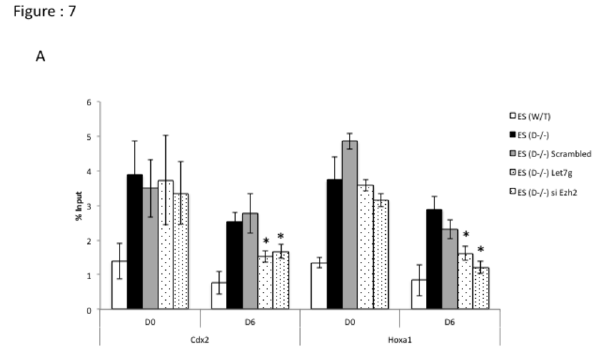
Figure 7. Transfecting Dicer -/- ES cells with let-7g miRNA and siRNA targeting Ezh2 reduces H3K27me3 at Hoxa1 and Cdx2 during retinoic acid induced differentiation. Cells were treated with let-7g miRNA and siRNA-targeting Ezh2 along with a scrambled negative control immunoprecipitated using an H3K27me3 specific antibody. Thereafter enrichment of H3K27me3 at Hoxa1 and Cdx2 loci